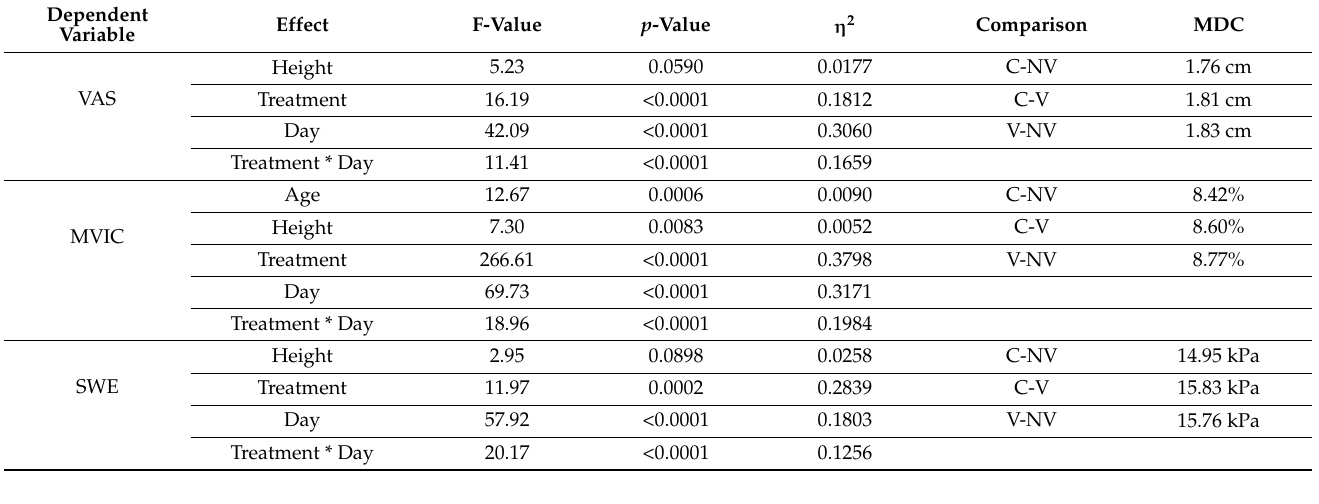
Table 1. Significance and Eta2 of effects analyzed in the final model for each dependent variable. Minimal detectable change (MDC) scores are calculated for group comparisons for each dependent variable at the 0.01 significance level.